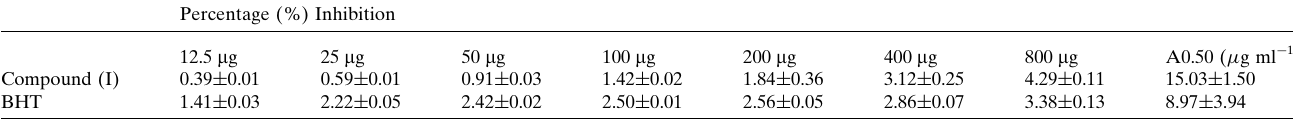
Table 2 Cupric ion reducing antioxidant capacity of compound (I).